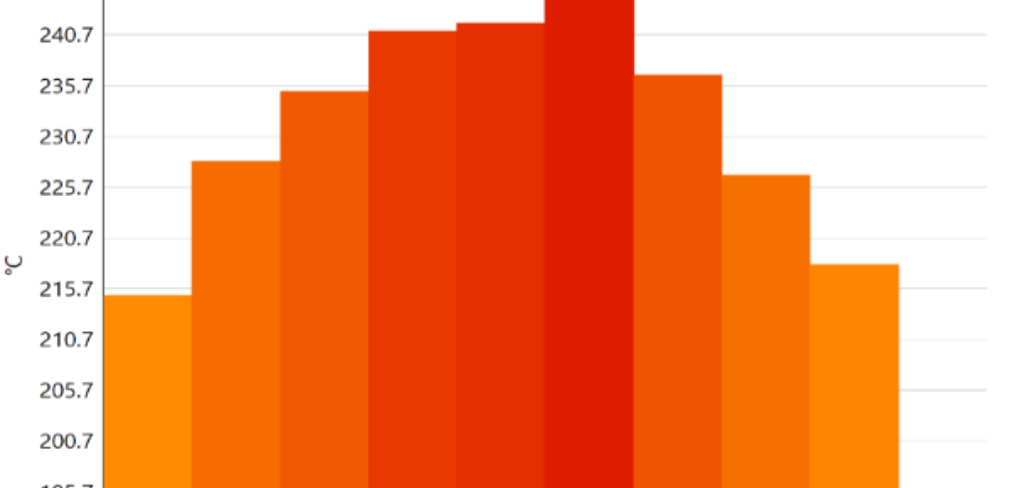
Figure 8. IR image ( top ) and the temperature profile ( bottom ) of the sensor surface with the heater feedback control.